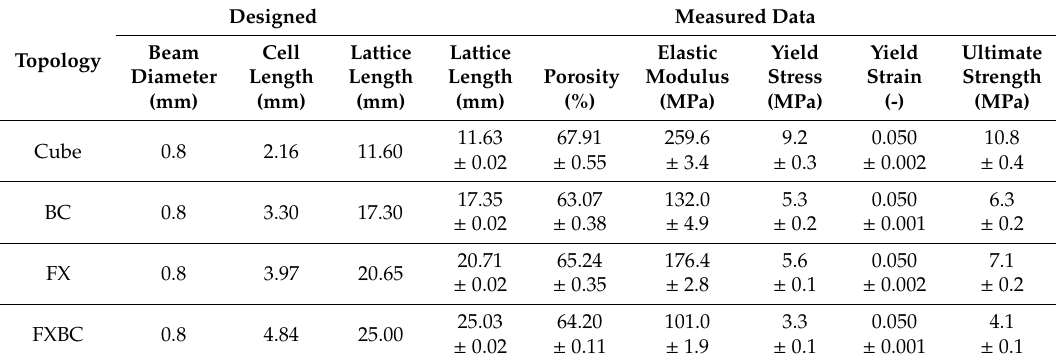
Table 3. Design and measurements for unit cell topologies.